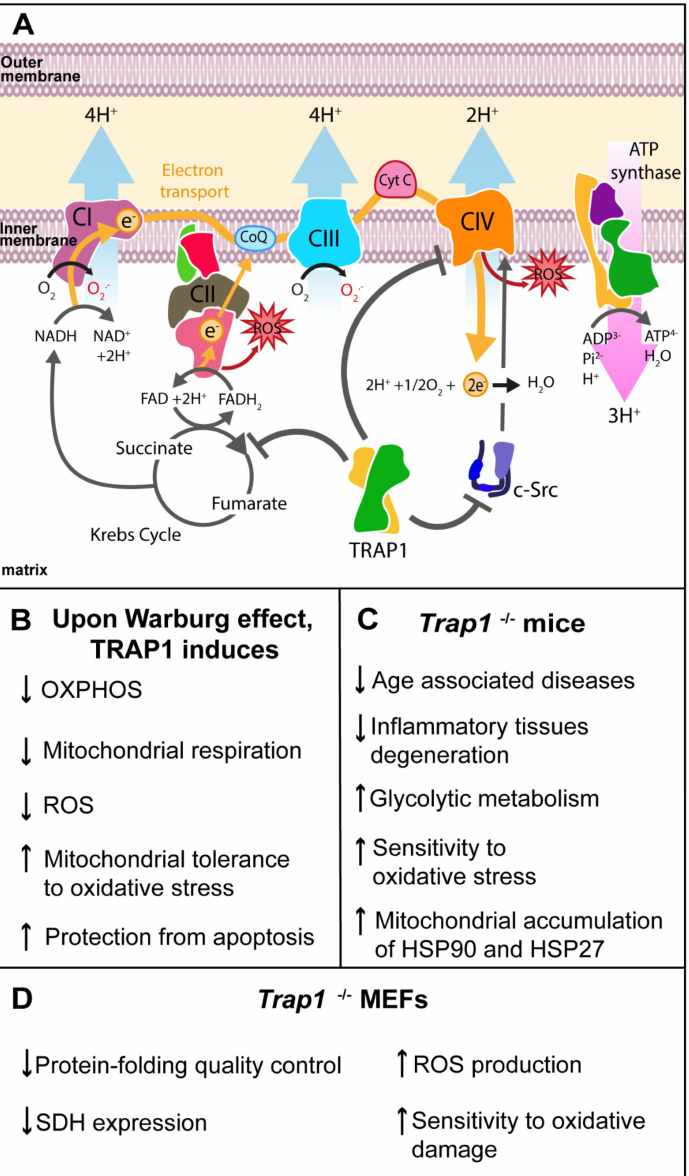
Figure 2. Role of TRAP1 in energetic metabolism regulation. ( A ) TRAP1 modulates oxidative phos- phorylation (OXPHOS) by interacting with proteins of mitochondrial electron transport chain (ETC), namely succinate dehydrogenase (SDH) and cytochrome oxidase, also known as complex II and com- plex IV, respectively. TRAP1 inhibits proto-oncogene tyrosine-protein kinase (c-Src) downregulating cytochrome oxidase activity. TRAP1 also inhibits SDH activity, resulting in less electron funneling and lower reactive oxygen species (ROS) generation as a side-reaction of ETC. ( B ) Upon conditions of shortage of oxygen, also known as Warburg effect, TRAP1 induces downregulation of OXPHOS, decreasing ROS production and mitochondrial respiration. Moreover, OXPHOS downregulation is associated with increased mitochondrial tolerance to oxidative stress, and protection from apoptosis; ( C ) Trap1 knockout mouse showed a reduced incidence of age-associated pathologies and inflamma- tory tissue degeneration. It also presented a switch to glycolytic metabolism, increased susceptibility to oxidative stress and increased mitochondrial accumulation of cytoprotective chaperones Hsp90 and Hsp27. ( D ) Trap1 knockout mouse embryonic fibroblasts (MEFs) exhibited loss of protein-folding quality control in mitochondria and decreased SDH expression. While showing increased ROS production and increased sensitivity to oxidative